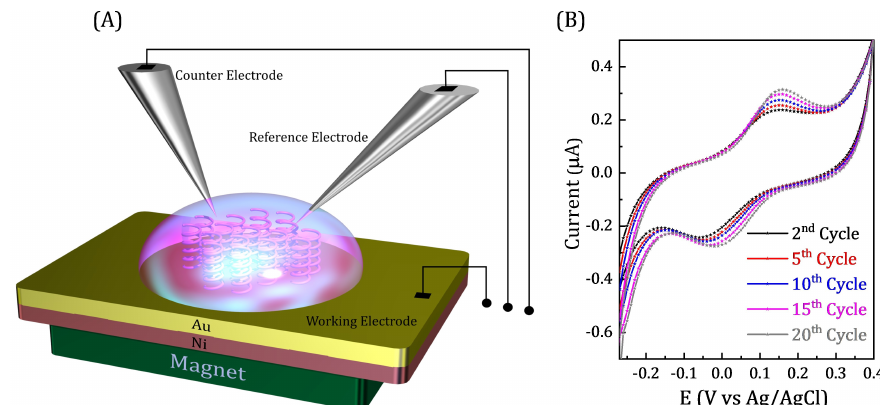
Figure 2. ( A ) Schematic presentation of drop magneto-electrochemistry for the deposition of enantiospecific adsorption. ( B ) Cyclic voltammetry recorded during the L-cysteine monolayer preparation. Note: scan rate 100mV/sec was maintained during each scan with total 20 cycles.